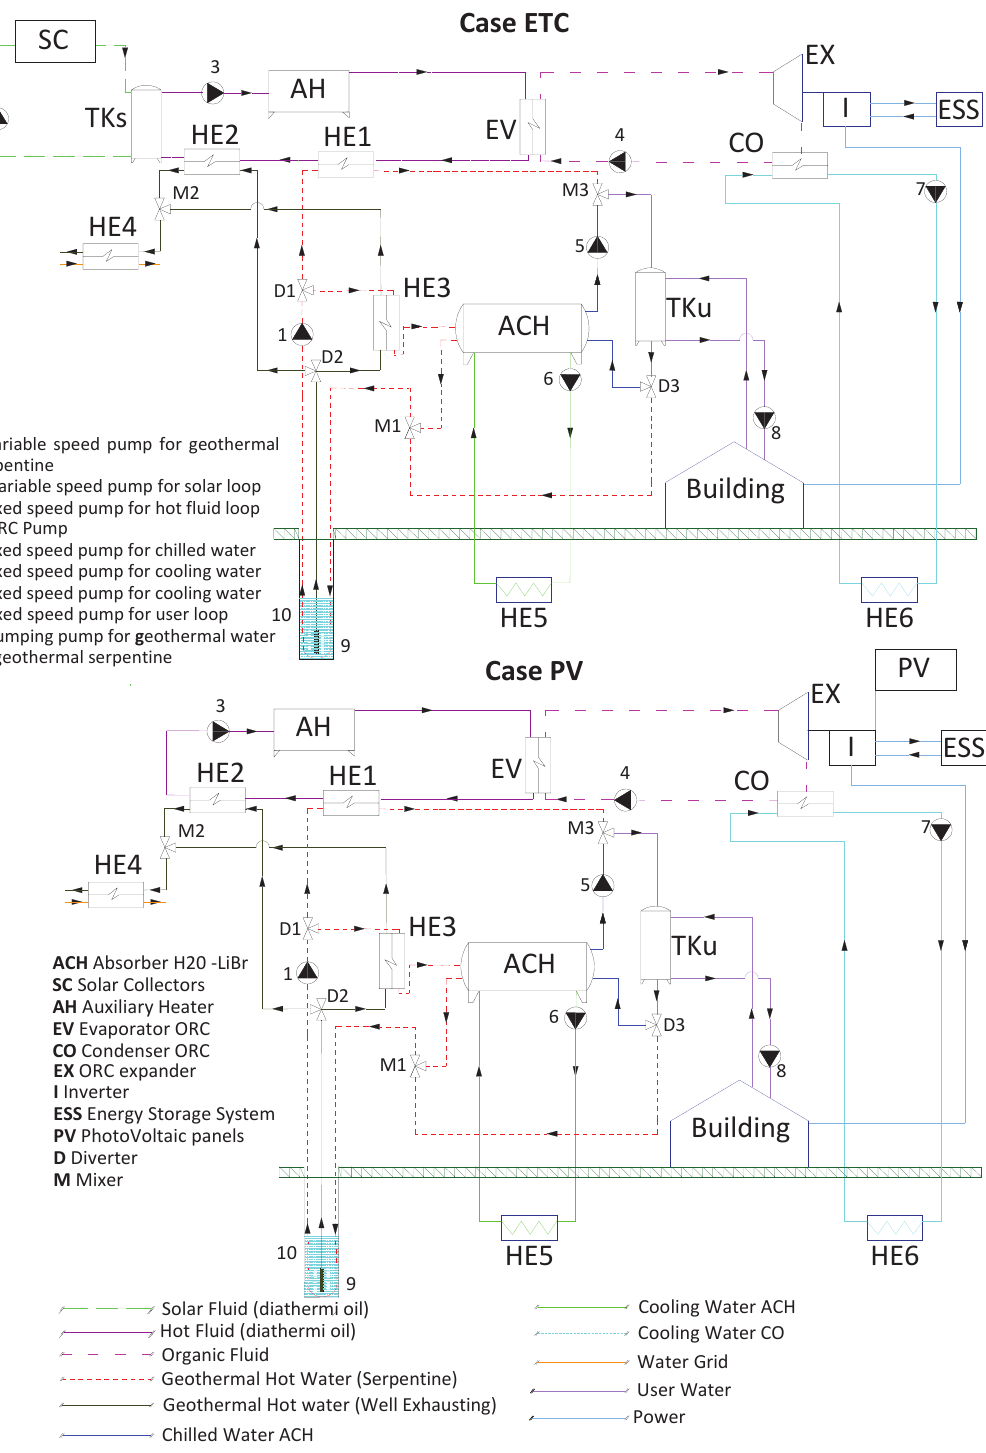
Figure 1. Systems layout: Case evacuated thermal collector (ETC, above) and Case photovoltaic (PV, below).